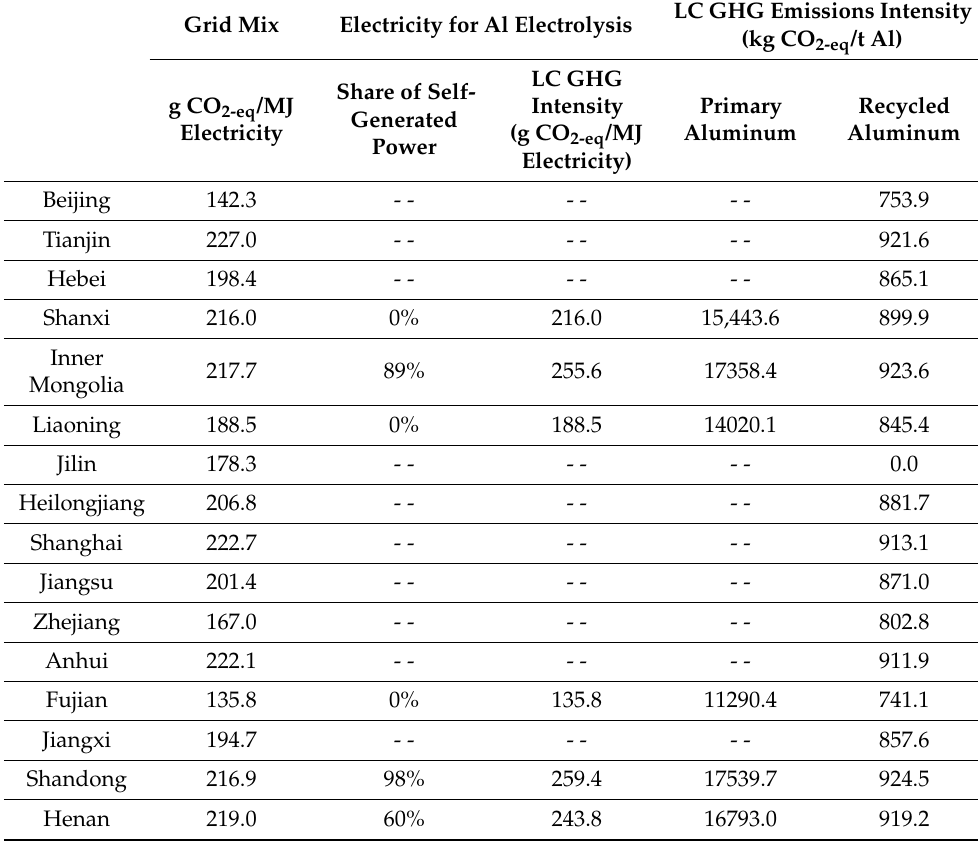
Table A1. Provincial and nationwide GHG intensity of electricity and aluminum